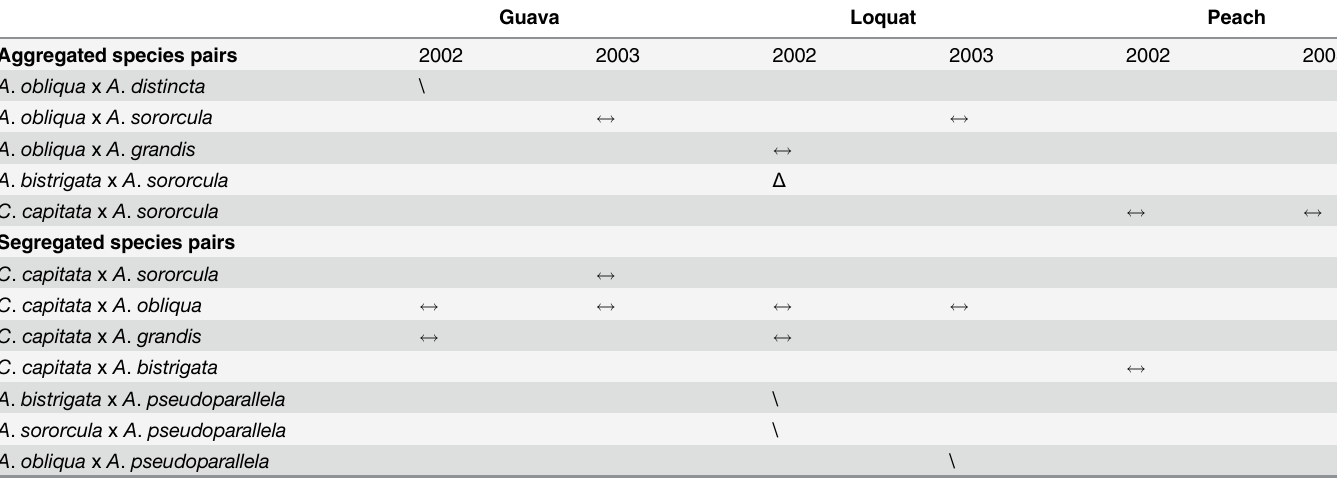
Table 5. Analysis of average air temperatures and Julian calendar dates (= season) for time periods of species presences and absences in statisti- cally significant species aggregations and segregations (see Table